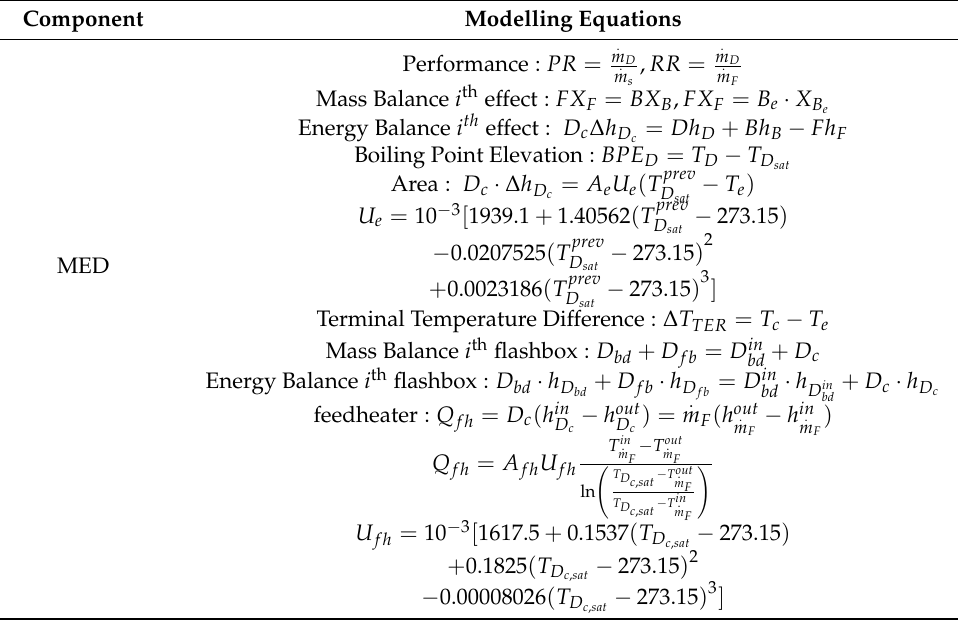
Table A1. Modelling equations for the multi-effect distillation (MED) system